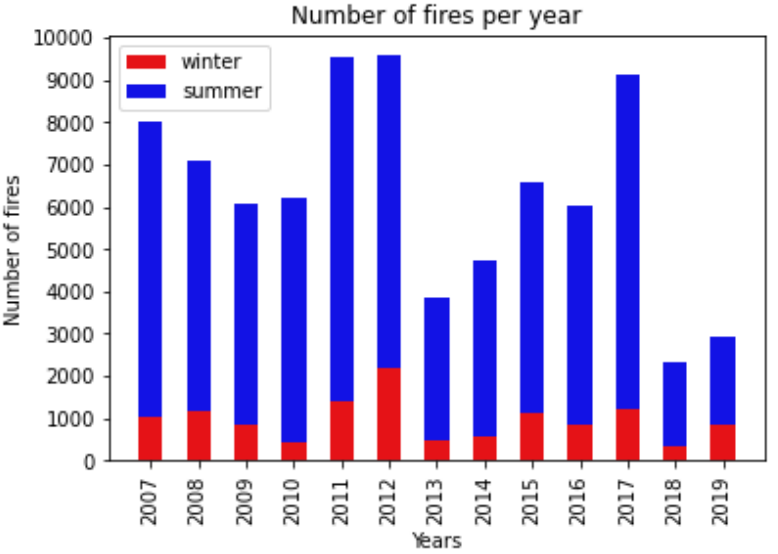
Figure 4. Seasonal number of fires in Italy per year based on the historical dataset used in this study (2007–2019). The wildfires occurred in winter season are presented in red while the ones occurred in summer season are presented in blue.